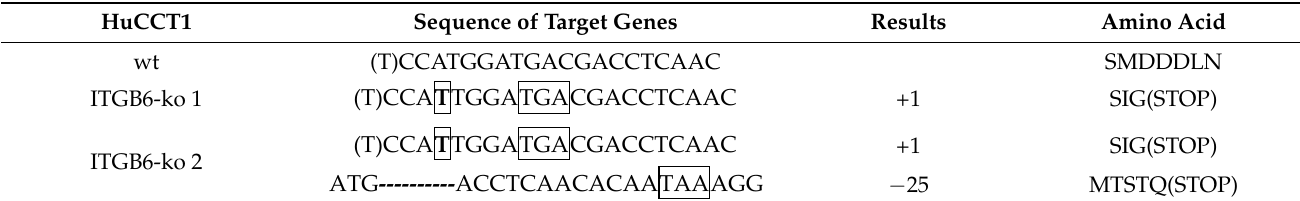
Table 1. Direct sequence analysis of target genes in ITGB6 -knockout monoclonal cells. HuCCT1